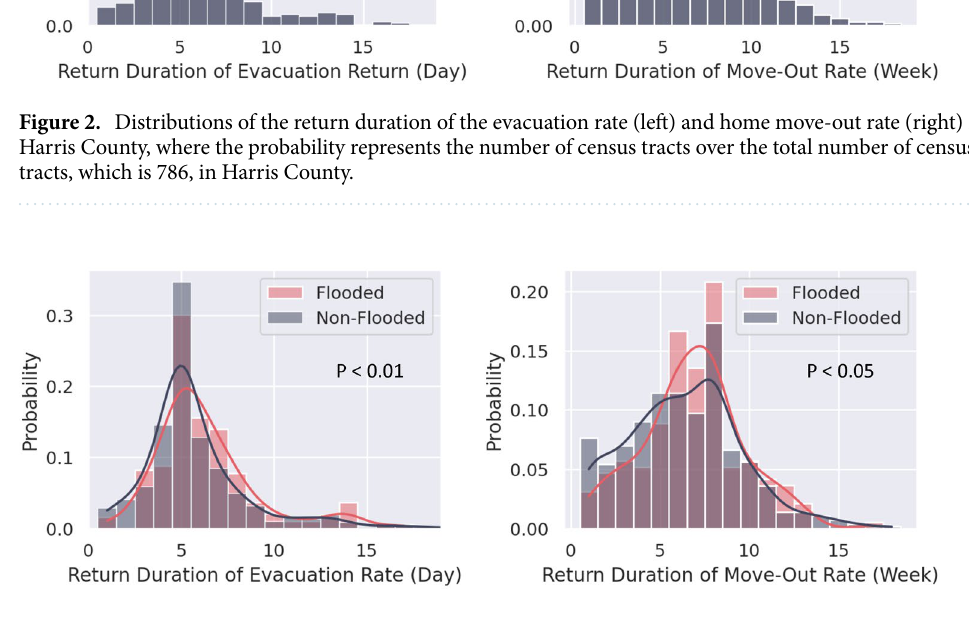
Figure 3. Distributions of the return duration of the evacuation rate (left) and home move-out rate (right) in flooded and non-flooded census tracts in Harris County, where the probability represents the percentage of census tracts. The results indicate that the durations for the flooded census tracts for both evacuation and move- out rates were significantly longer than for the non-flooded census tracts. In this study, we identified 193 flooded and 593 non-flooded census tracts in Harris County. The solid lines are kernel density estimations